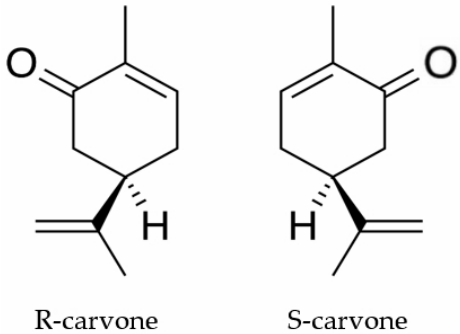
Figure 1. The chemical structures of R-carvone and